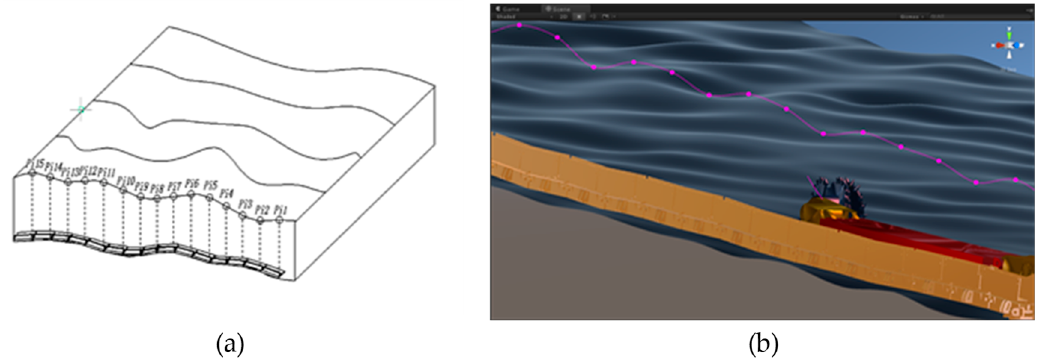
Figure 11. Schematic diagram: ( a ) the map of cutting points ( b ) the effect of cutting points in Unity3D.